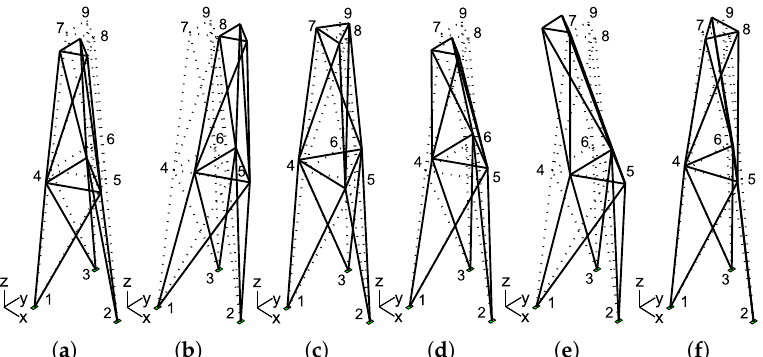
Figure 12. First six mode shapes of the tower structure: 1st bending mode in Y direction (BY1) ( a ), 1st bending mode in X direction (BX1) ( b ), 1st torsional mode (T1) ( c ), 2nd bending mode in Y direction (BY2) ( d ), 2st bending mode in X direction (BX2) ( e ) and 2nd torsional mode (T2) ( f